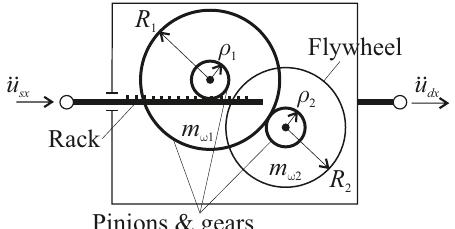
Figure 2. Rack–pinion–flywheel supplemental rotational inertia